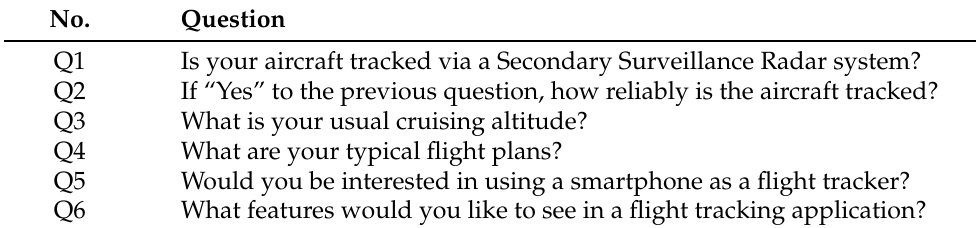
Table 2. Interview questions with the pilots.